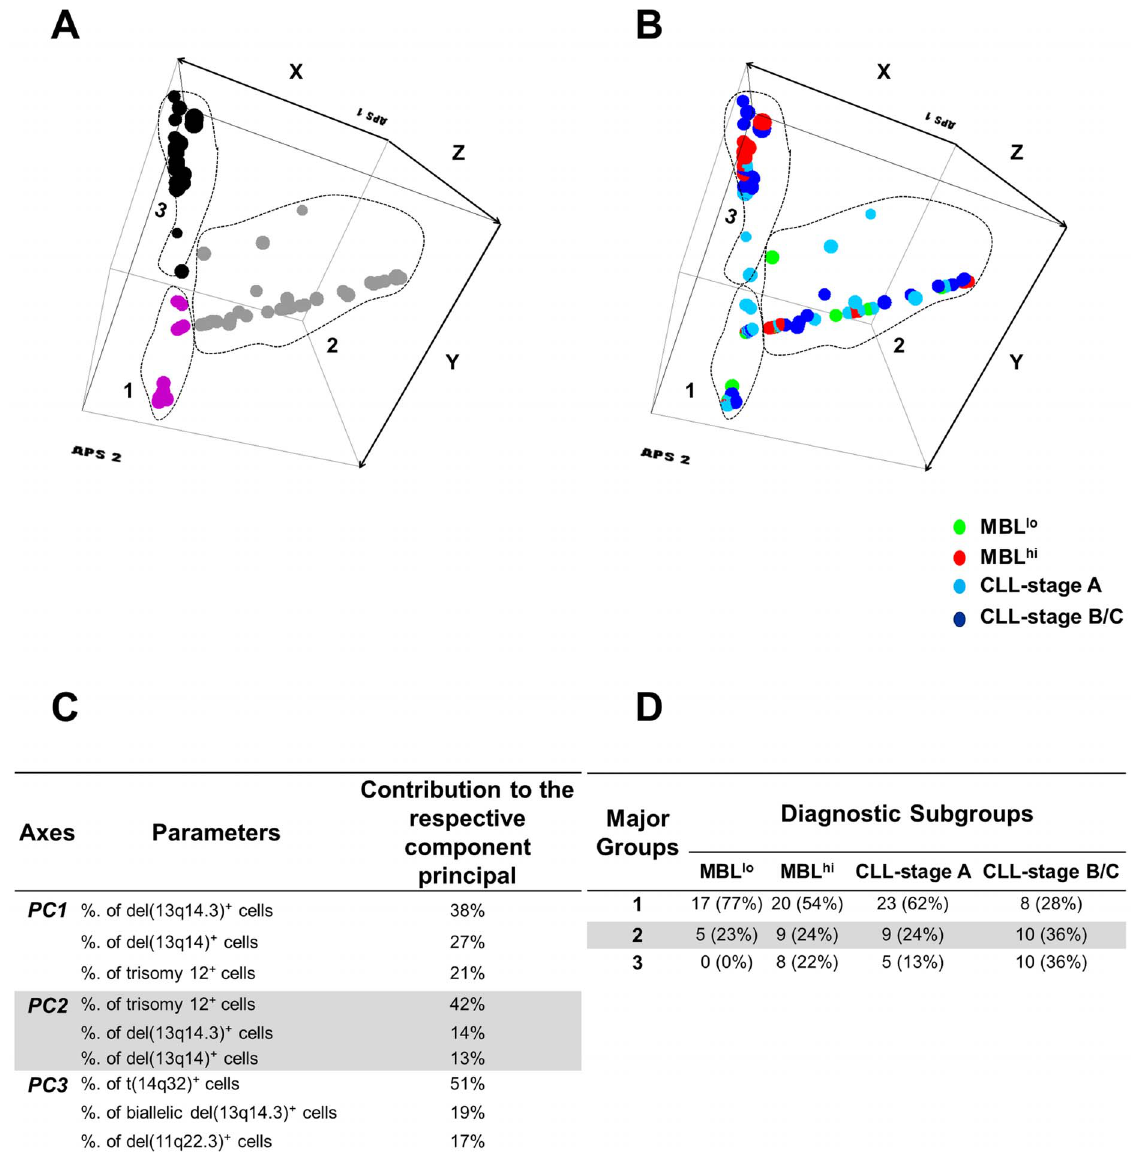
Figure 2. Principal component analysis (3-dimensionalX-Y-Z axis view of PC1 vs PC2 vs PC3, respectively) for comparison of ‘‘low- count MBL’’ (MBL lo ), ‘‘high-count MBL’’ (MBL hi ) and CLL B-cell clones according to the absolute number of clonal B cells/ m L and the pattern of cytogenetic alterations (including the percentage of altered cells), using the Infinicyt TM software. Overall, MBL lo , MBL hi and CLL cases are clustered into groups distinguished by different colors in A: magenta, gray, and black circles ( A ). The distribution of MBL lo , MBL hi , CLL- stage A and CLL-stage B/C clones are coloured differently in B: MBL lo , green; MBL hi , red, CLL stage A and B/C light blue and dark blue, respectively ( B ). The most informative parameters contributing to the best discrimination between 1 6 1 comparisons of the three groups are displayed in a decreasing order of percentage contribution to each of the principal component ( C ); Distribution of MBL lo , MBL hi and CLL clones among the three major groups defined in panel A by principal component analysis ( D ); CLL, chronic lymphocytic leukemia; MBL, monoclonal B lymphocytosis; PC: principal component.